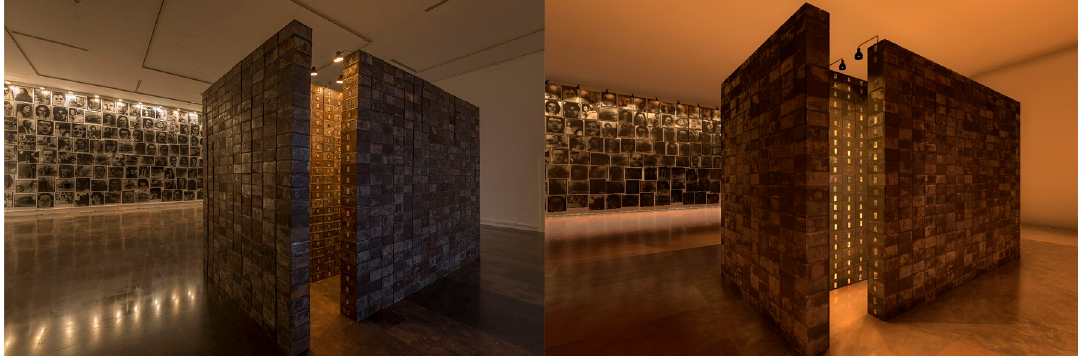
Fig 4. Comparison between the real museum (left) and the virtual museum